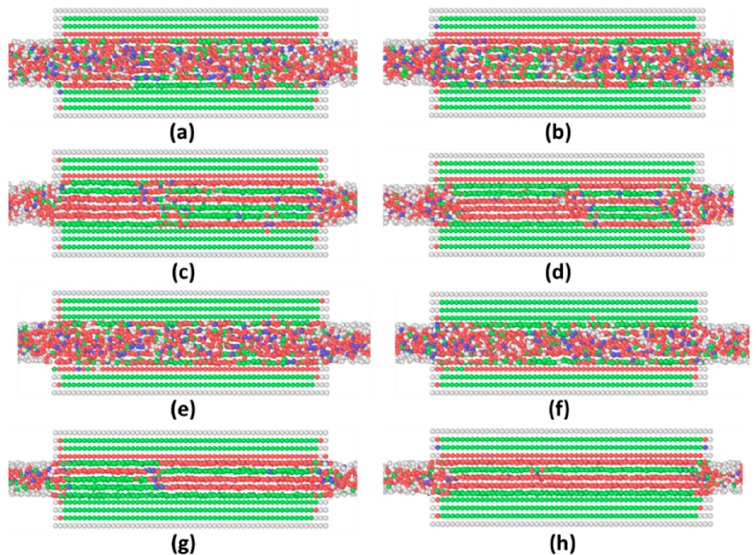
Figure A1. The equilibrium configurations of argon molecules confined between two commensurate contacts observed in LVMD simulations with varying thicknesses: ( a ) 6.5 Layer + 1.0Å, ( b ) 6.5 Layer + 0.5Å, ( c ) 6.5 Layer, ( d ) 6 Layer, ( e ) 5.5 Layer + 1.0Å, ( f ) 5.5 Layer + 0.5Å, ( g ) 5.5 Layer, and ( h ) 5 Layer. Only central walls are shown. They are consistent with those observed in GCMC/MD simulations with chemical potential μ = − 2.21 kcal/mol, as shown in Figure 6.